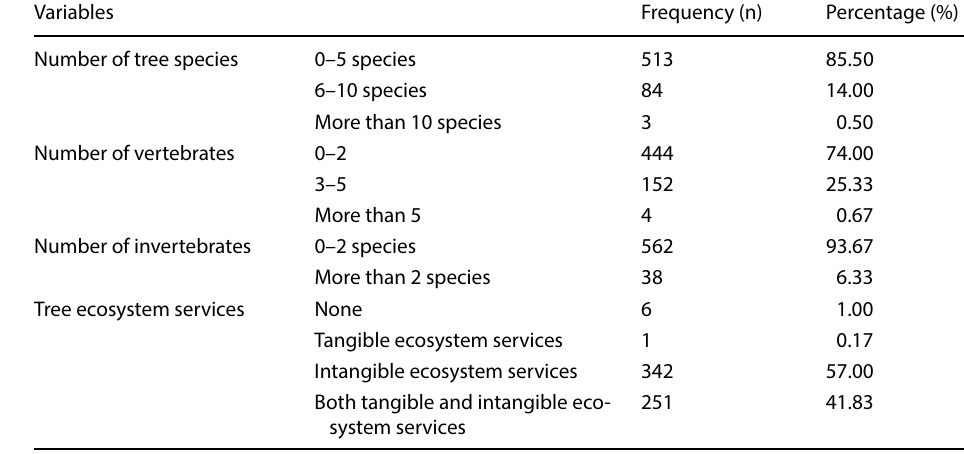
Table 4 Students’ knowledge of the tree species and zoological diversity in their schoolyards (n =